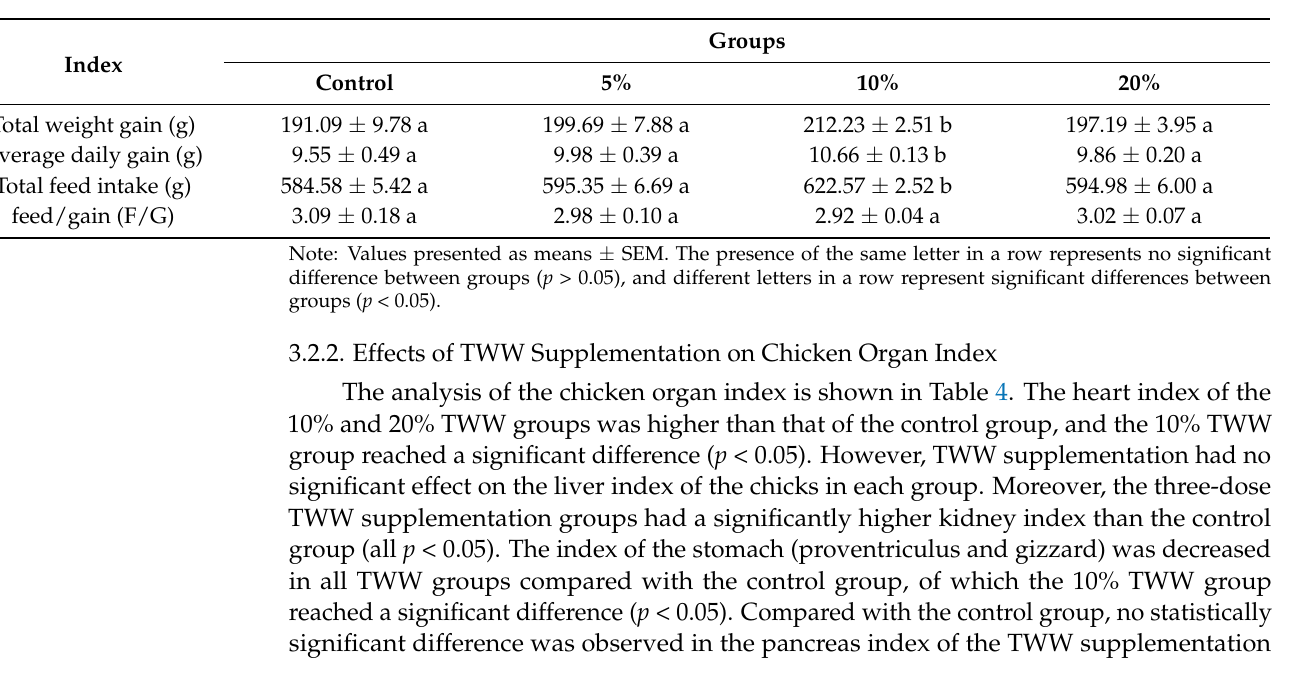
Figure 1. Analysis of microbial flora in naturally fermented TWW. ( a ) The OUT numbers of microbial flora. ( b ) Venn diagram analysis of microbial flora. ( c ) Relative abundance of microbial flora at the genus level. ( d ) Relative abundance of Lactobacillus species. Table 3. The effect of FTWW on the growth performance of